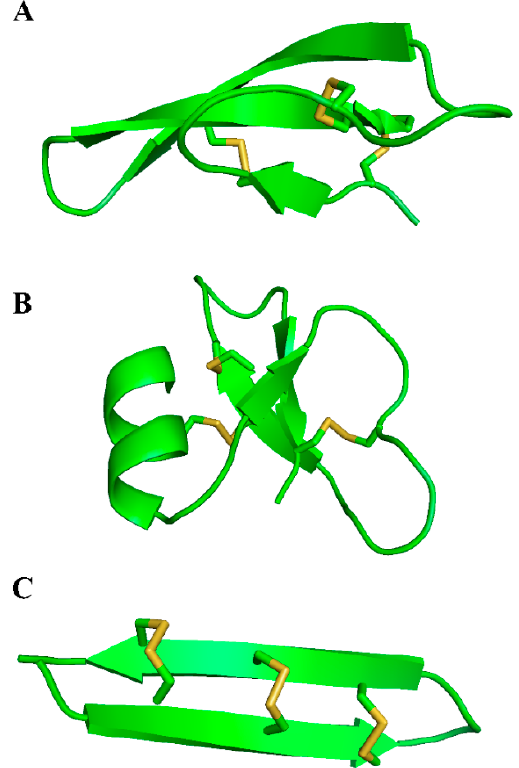
Figure 1. Structure of human defensins. Crystallographic structure of human α -defensin 1 ( A ); crystallographic structure of human β -defensin 1 ( B ); and the NMR-structure of θ -defensin 2 ( C ). Yellow shows the disulfide bridges.